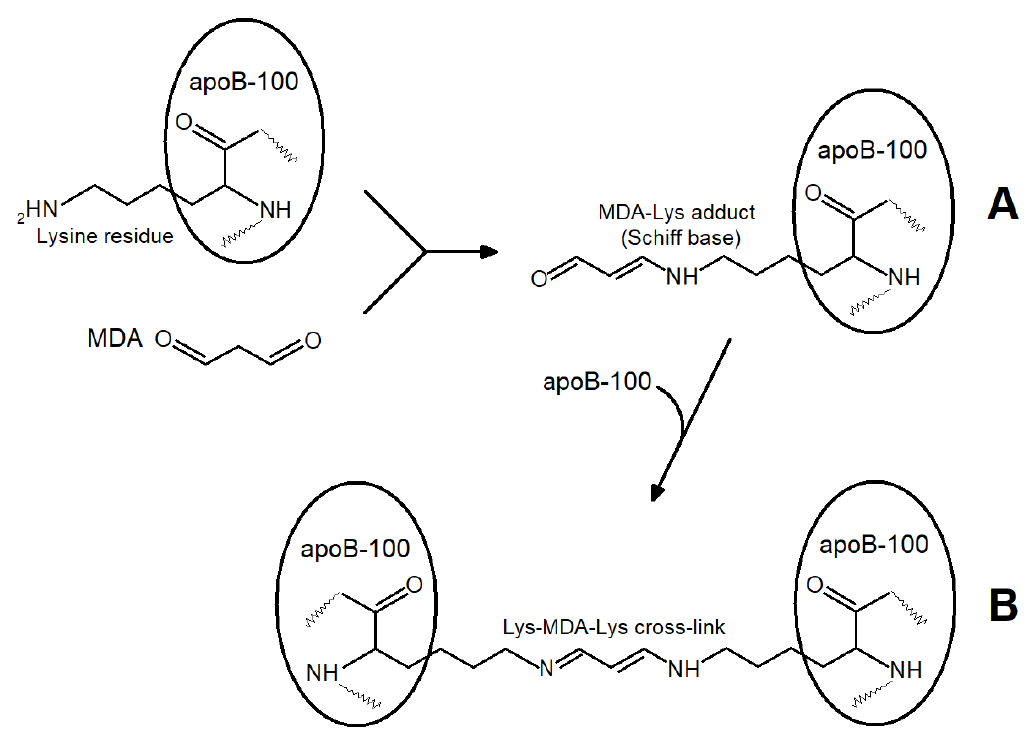
Figure 3. Reactions of end lysine residues of apoprotein B-100 LDL particles with MDA aldehyde groups: ( A )— Maillard reaction: formation of MDA-lysine adduct of apoprotein B-100 LDL (Schiff base); ( B )—participation of second MDA aldehyde group in formation of intermolecular cross-linking between two LDL particles.